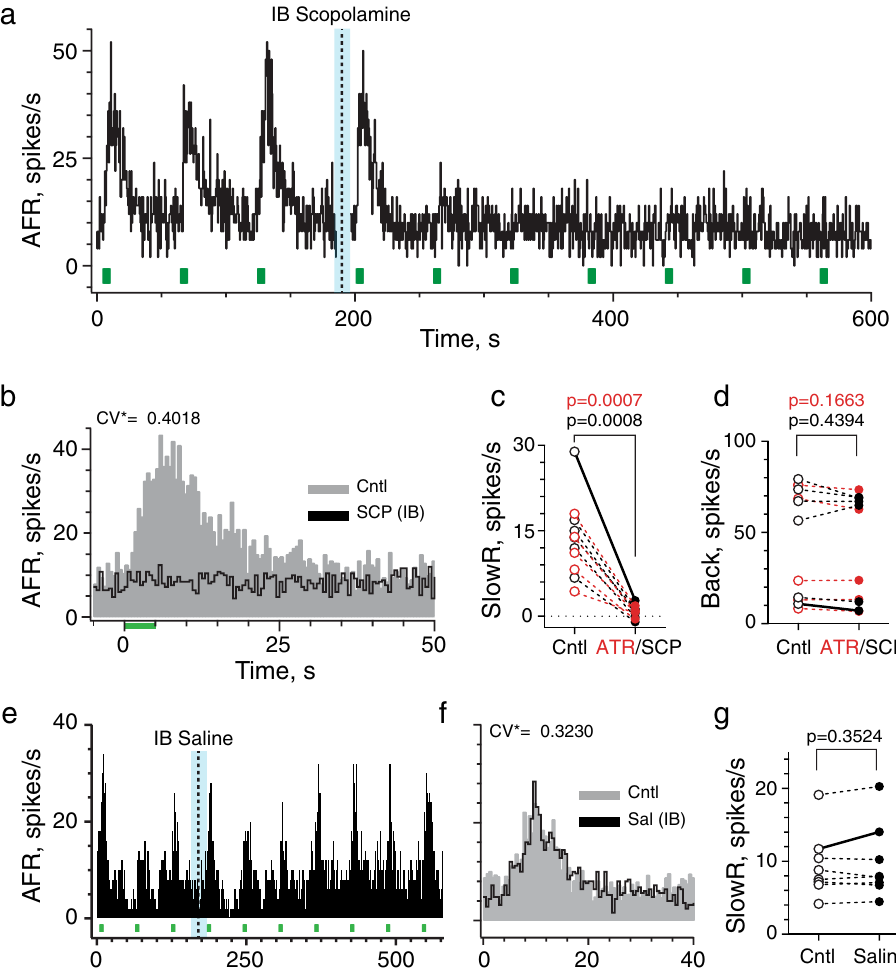
Figure 6. Intrabulla application of atropine and scopolamine rapidly blocks efferent-mediated slow excitation in mouse vestibular afferents. ( a ) Continuous response histogram from an irregular afferent shows changes in afferent firing rate (AFR) during midline efferent stimulation (green bars, 333/s for 5 s every 60 s) before and after intrabulla delivery (IB) of scopolamine (30 µl at 0.5 mM). Scopolamine was delivered to the middle ear in a 10-s window between trials (blue box and dashed line). ( b ) Corresponding average response histograms from the same afferent in panel ( a) were generated separately for 5 efferent shock trains delivered before and after IB scopolamine (SCP). Binning = 500 ms. ( c ) Values of mean peak slow excitation during control (Cntl) and atropine (red, ATR) or scopolamine (black, SCP) conditions. ( d ) Values of mean background discharge during control (Cntl) and atropine (red, ATR) or scopolamine (black, SCP) conditions. Example histograms shown in panel ( b) appear as solid lines in panels ( c,d) . ( e ) Continuous response histogram from an irregular afferent shows changes in afferent firing rate (AFR) during midline efferent stimulation (green bars, 333/s for 5 s every 60 s) before and after intrabulla delivery of saline (30 µl). Saline was delivered to the middle ear over a 10-s window between trials (blue box and dashed line). ( f ) Corresponding average response histograms from the same afferent in panel e were generated separately for efferent shock trains delivered before (Cntl) and 3–4 min after IB saline (Sal). The y-axis labels are the same as panel ( e ). Binning = 500 ms. ( g ) Values of mean peak slow excitation during control (gray, Cntl) and after IB saline (black, ATR). Example histograms shown in panel ( f) appear as solid lines in panels ( g) . Indicated p values from comparisons made in panels ( c , d , g) using a paired t